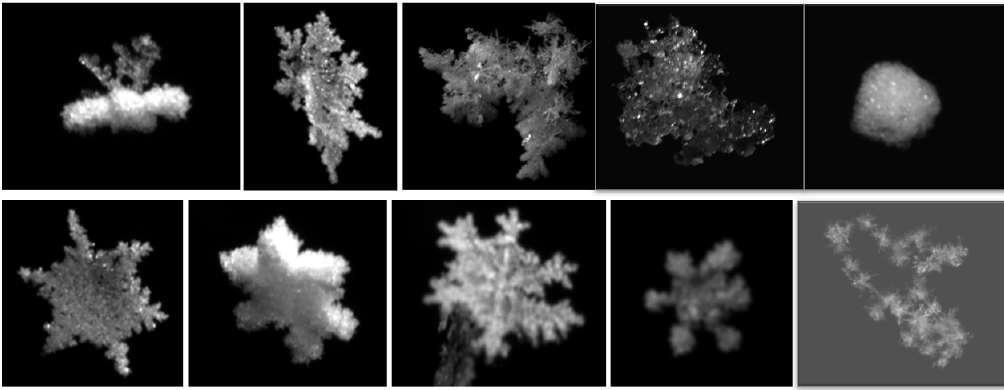
Figure 2. Characteristic examples of images of snowflakes with contrasting forms collected by the MASC (Figure 1) at the MASC + Radar (MASCRAD) field Site during the 2014/2015 MASCRAD winter campaign.